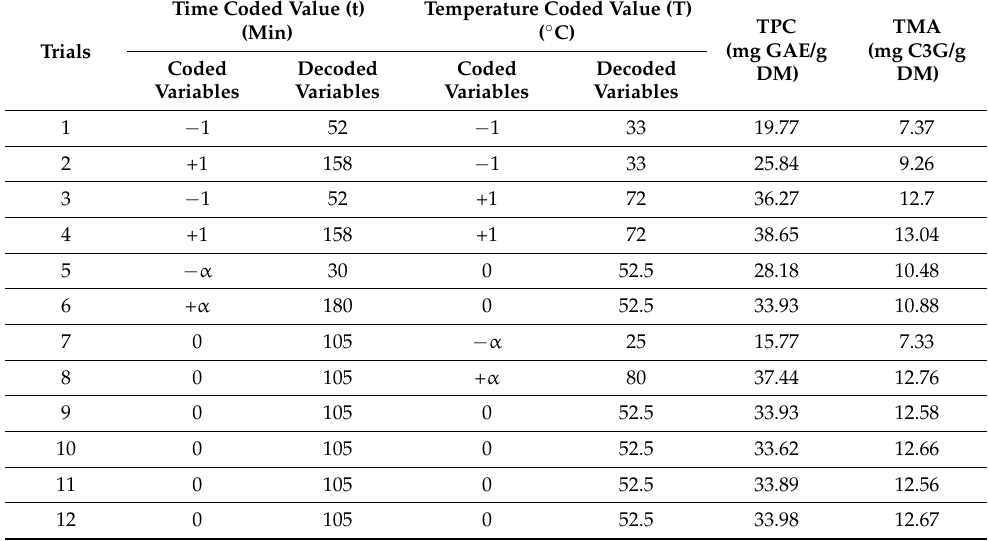
Table 1. TPC and TMA values obtained according to the response surface experimental design by infrared-assisted extraction.